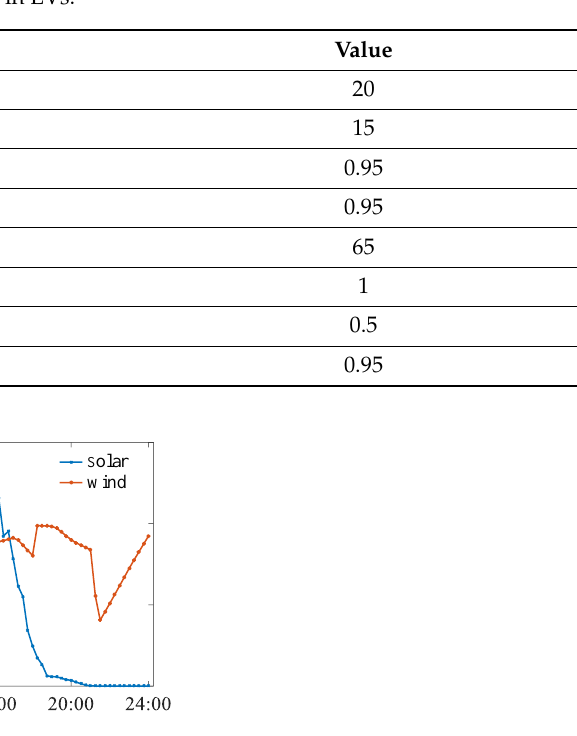
Figure A2. The numbers of three kinds of EVs. References 1.